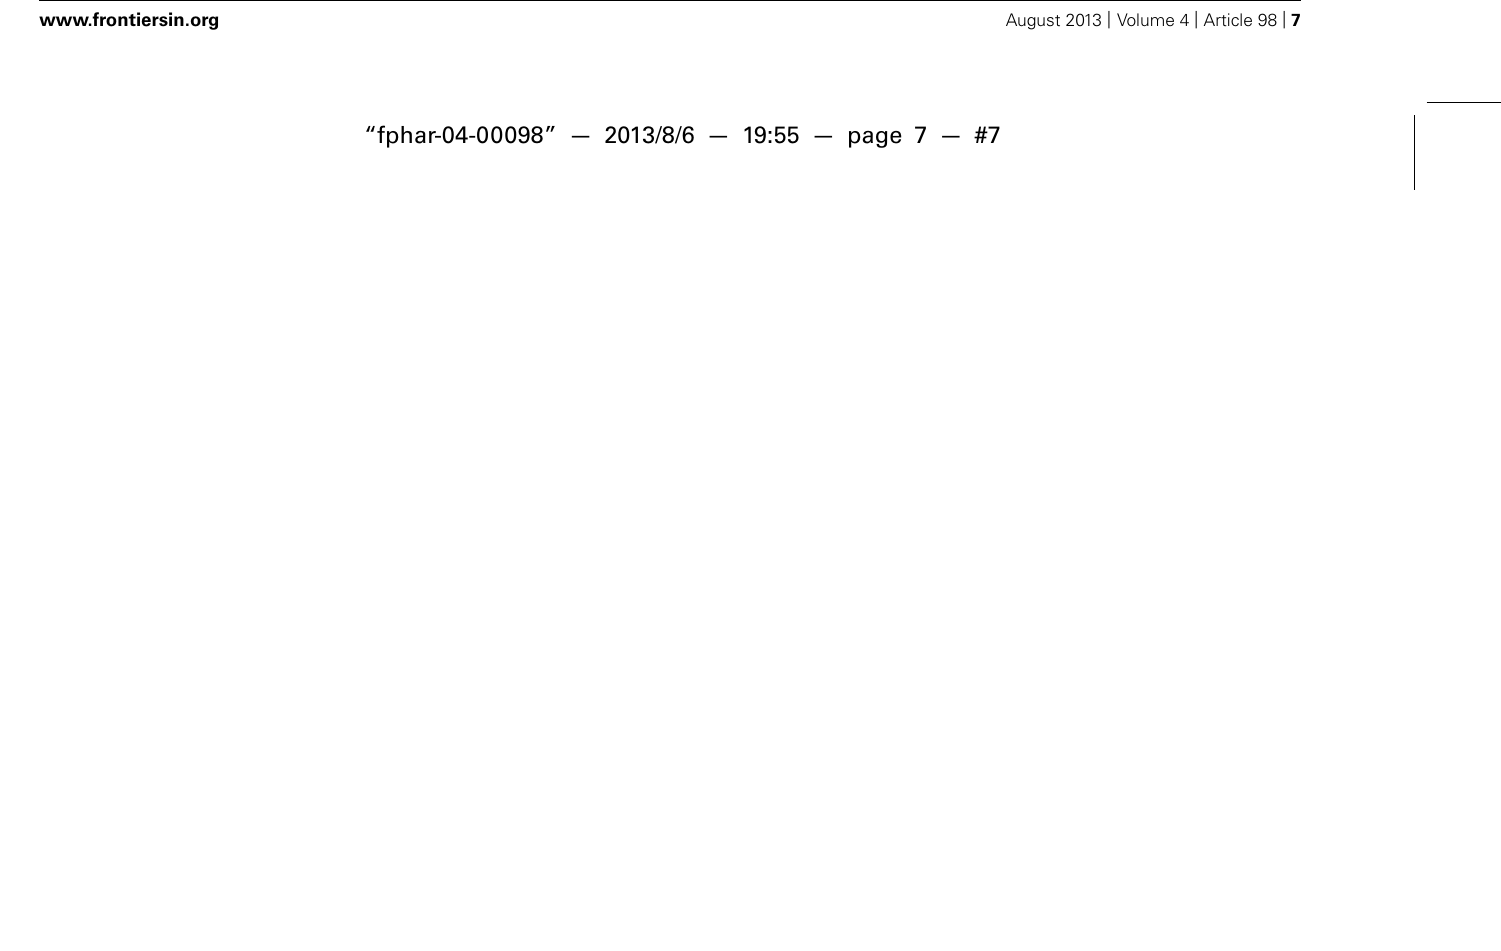
correlated with behavioral data in this protocol, suggesting that a BDNF + SSRI combination may offer new alternatives to treat mood disorders (from Deltheil etal., 2009). * p < 0.05, *** p < 0.001 when compared to the vehicle-treated group; § p < 0.05 when compared to the paroxetine/vehicle-treated group and paroxetine/BDNF-treated group; @@ p < 0.01 when compared to the BDNF/vehicle-treated group and BDNF/paroxetine-treated group (two-way ANOVA, Fisher’s PLSD post hoc test).